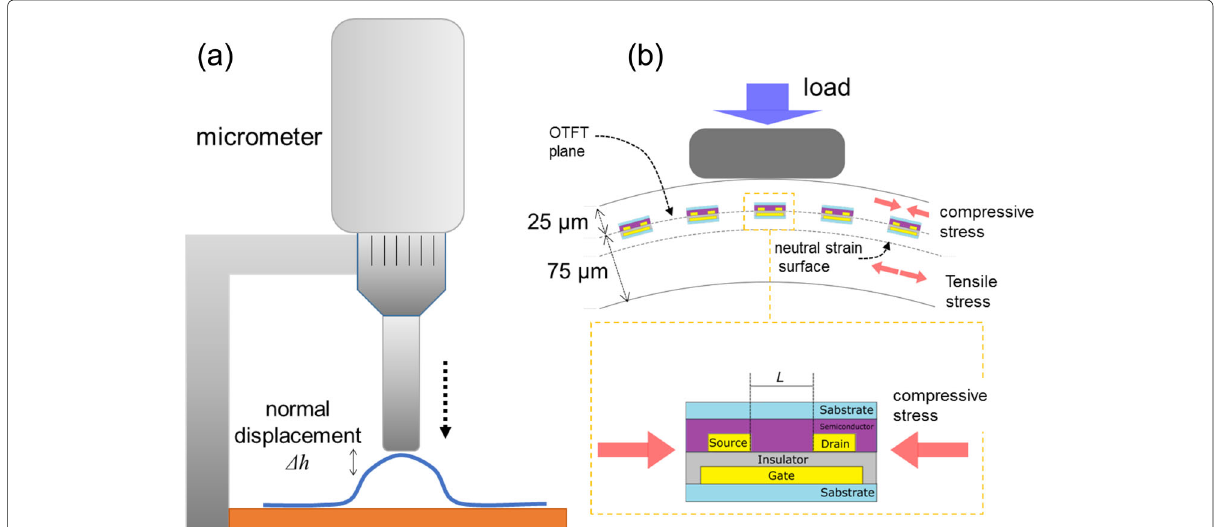
Fig. 1 a Schematic illustration of the tactile sensitivity tester, which consisted of a micrometer and sample stage. The sample was pressed by the rod of the micrometer in the normal direction. The normal displacement of (cid:2) h is the distance from the initial top height of the fingertip-shaped surface to the height of the pressed surface. b Schematic principle of tactile sensing by OTFT array. Electronic devices placed on a neutral strain surface are not exposed to lateral strain because the tensile and compressive strain cancel each other on the neutral strain surface [27–31]. However, the OTFTs placed on the off-neutral strain surface were exposed to lateral compressive strain due to the slight distortion of the fingertip-shaped curved